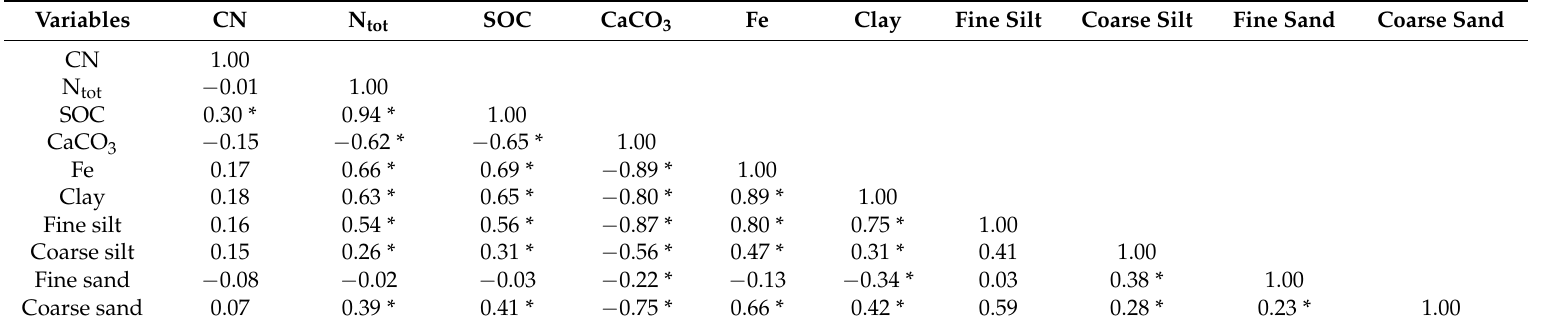
Table 5. Pearson correlation table of the topsoil properties (112